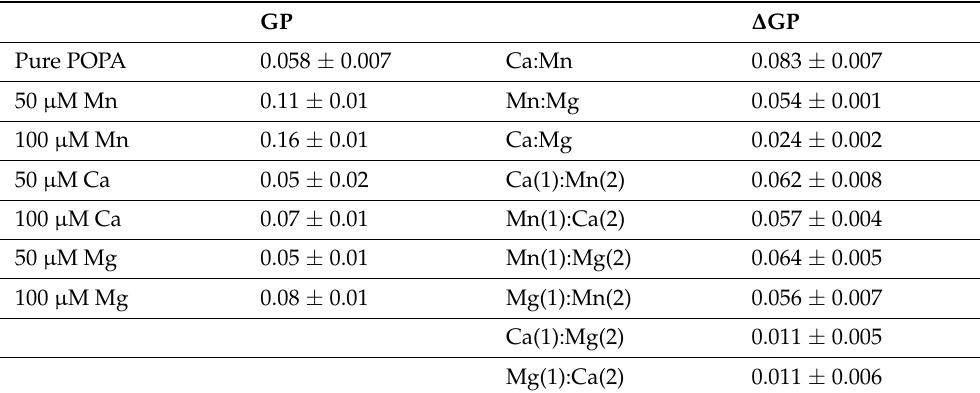
Table 1. Tabulated GP and ∆ GP values of POPA lipid with varying concentration of Mn, Ca, Mg and metal mixtures.